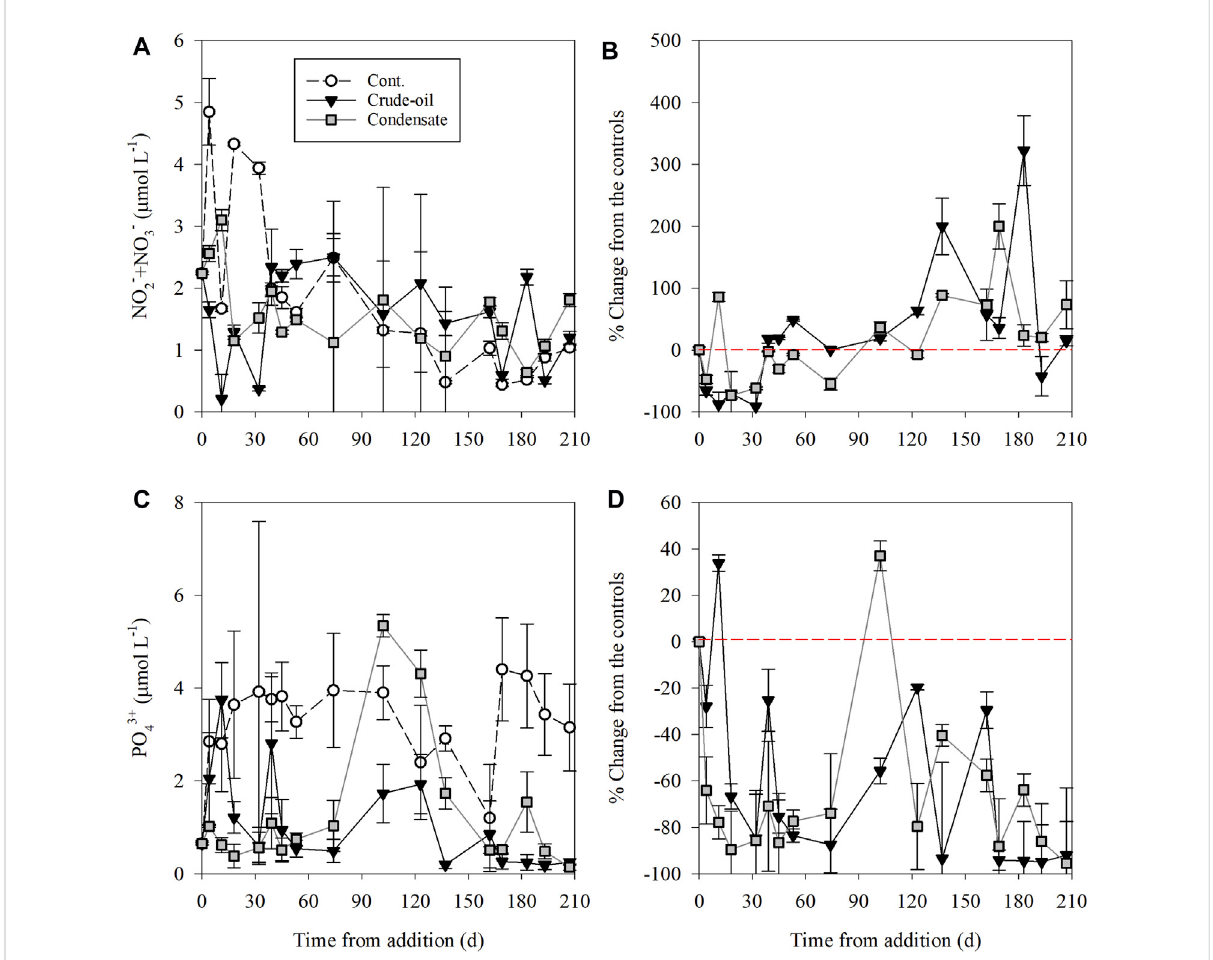
FIGURE 2 The temporal variability of porewater NO 2 − + NO 3 − (A, B) and PO 4 3+ (C, D) following crude oil (black triangle) and gas condensate (grey square) additions and in the unamended control benthocosms (white dots). Values shown are the average of three independent ‘ biological ’ replicates and their standard deviations. The red dashed line indicates no change between the treatments and the unamended controls at each